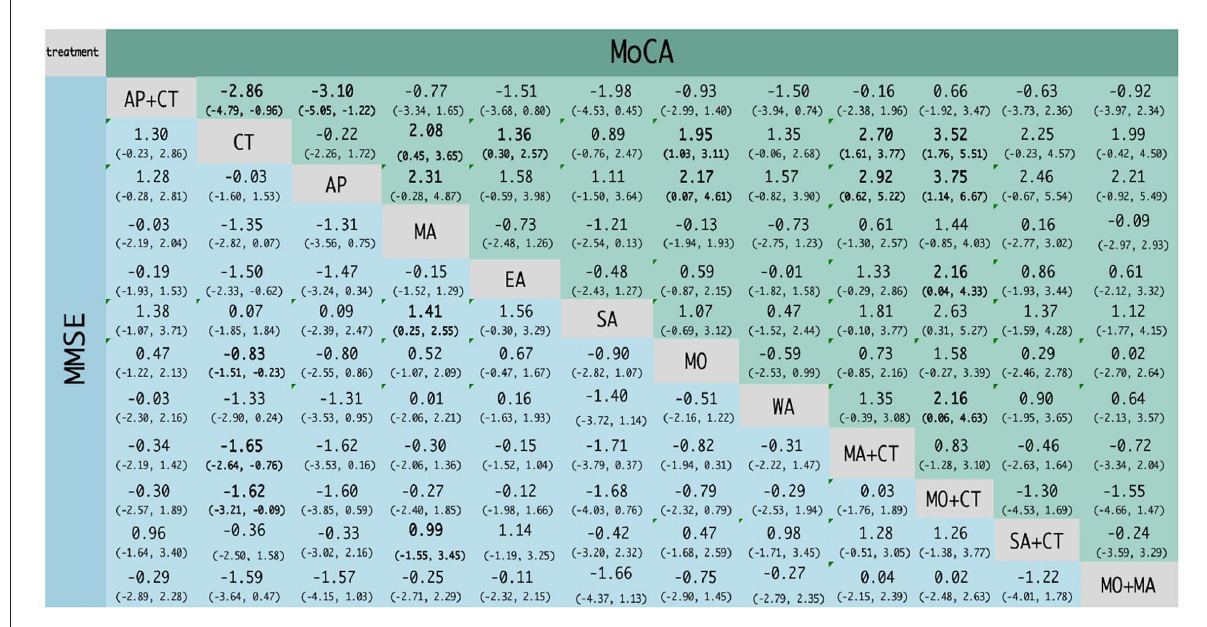
FIGURE4 Network meta-analysis results for MMSE and MoCA scores. The bold font indicates a statistical difference.